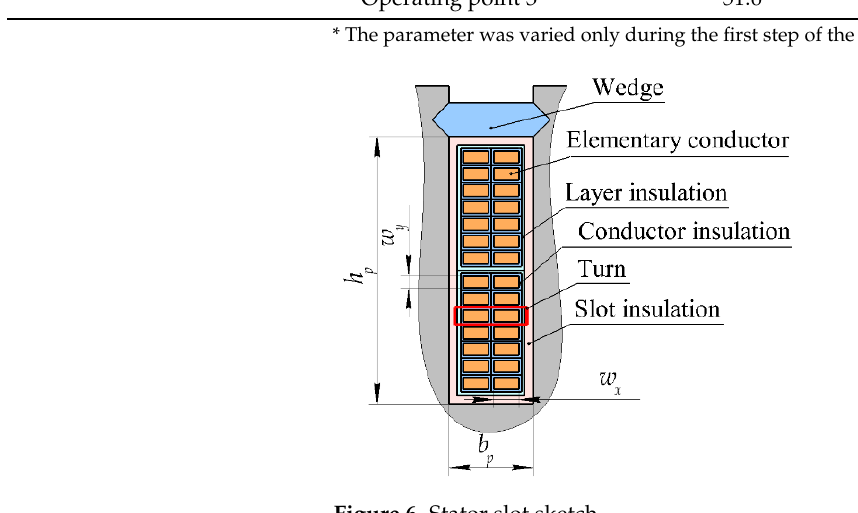
Figure 6. Stator slot sketch.